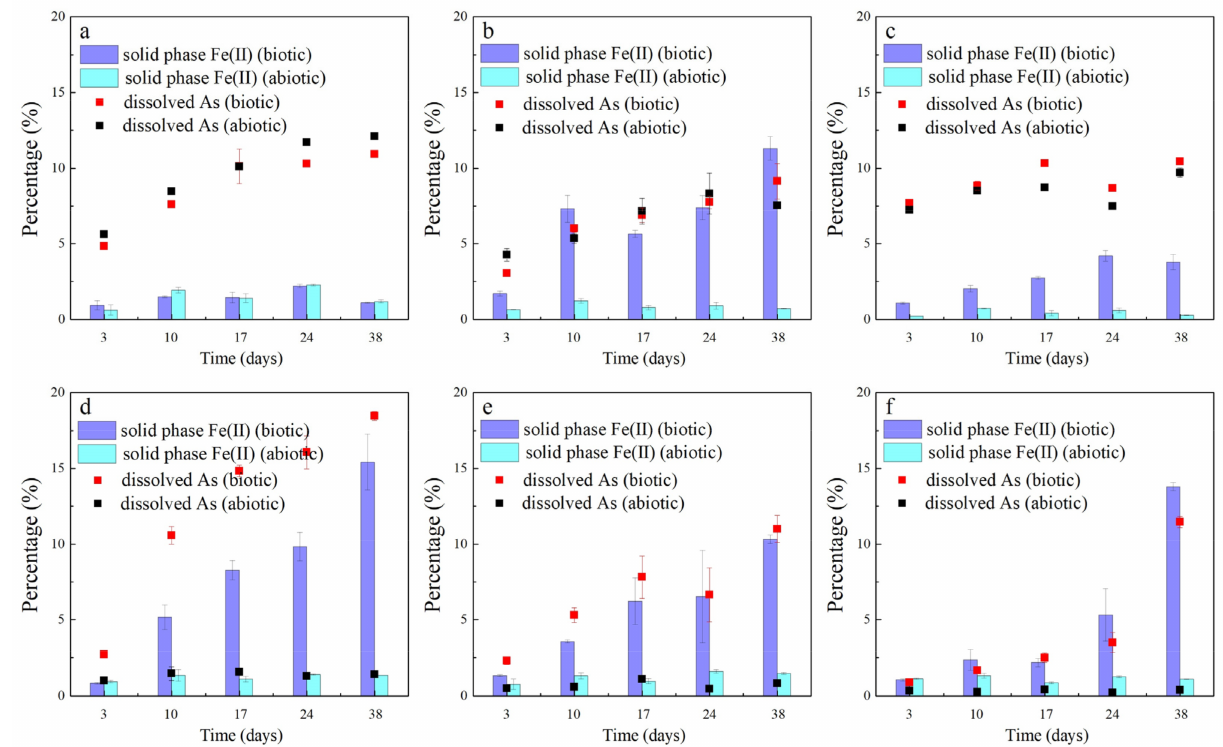
Figure 2. Variation in dissolved As in the supernatant and solid-phase Fe(II) as percent extracted of total in soil under biotic and abiotic conditions with different LMWOAS amendments in unremediated soils. ( a ) Oxalate, ( b ) citrate, ( c ) phytate, ( d ) malate, ( e ) lactate, ( f )